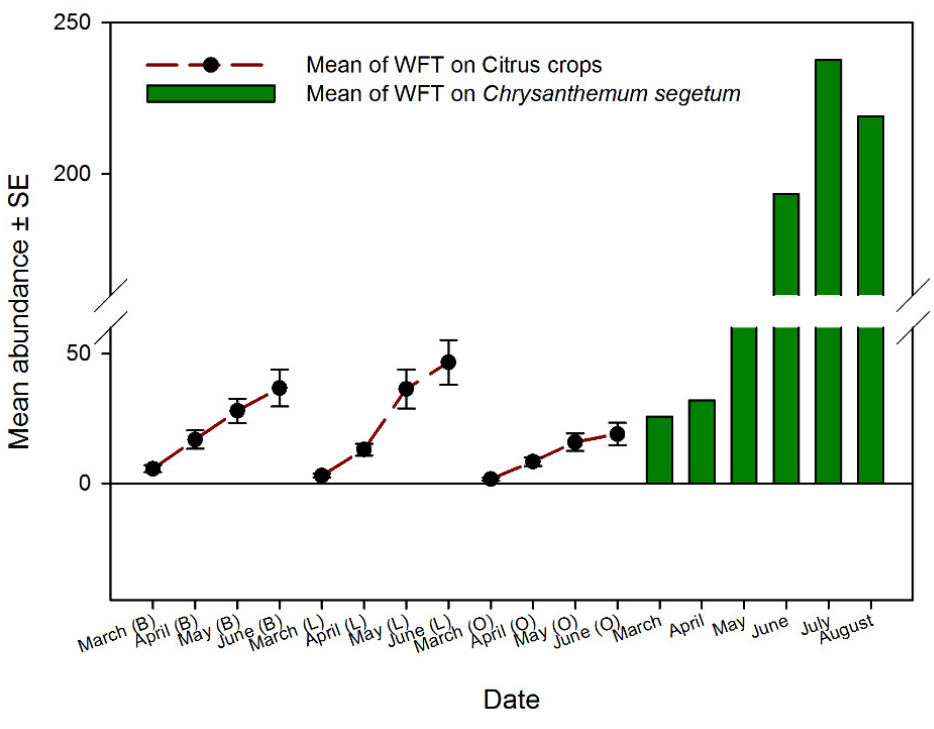
Figure 7. Monthly temporal dynamics of WFT presence on wild plant C. segetum and citrus crops (B = bergamot, L= lemon, O = orange).